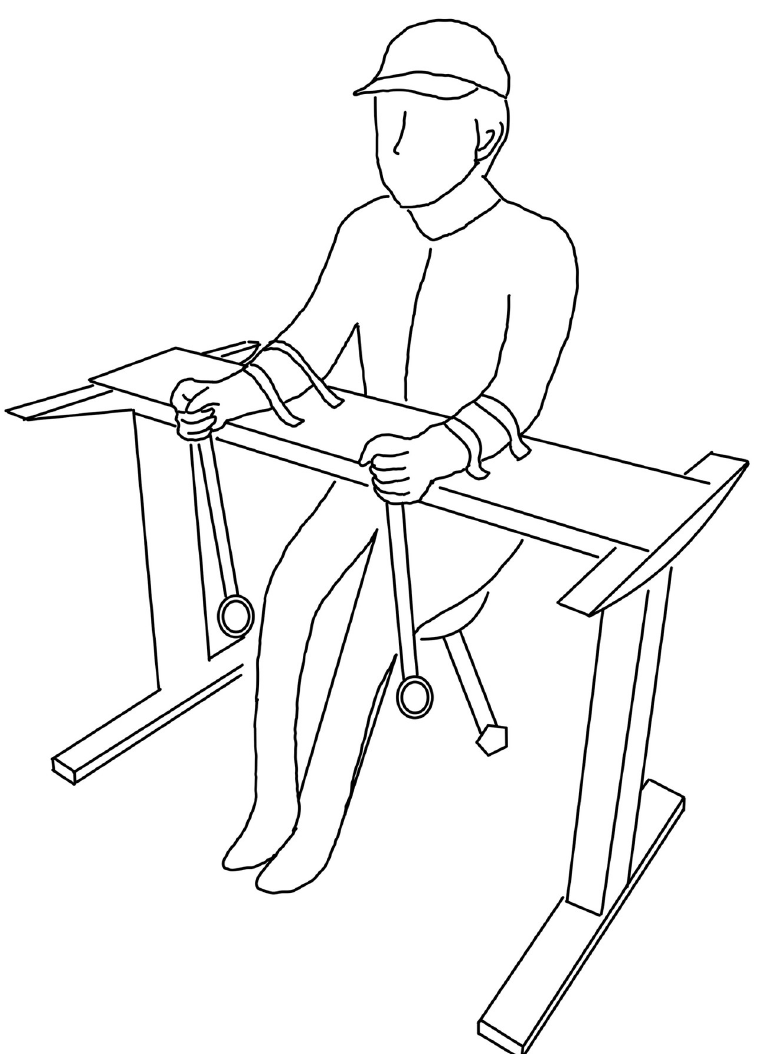
Fig 1. Experimental setup for the immobile